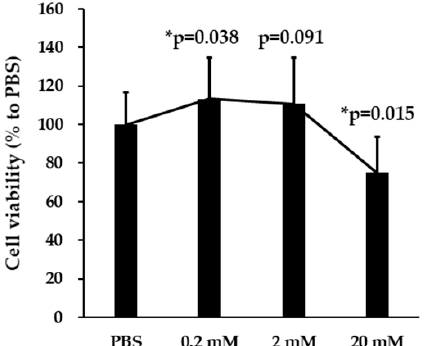
Figure 1. Valproic acid (VPA) has reciprocal concentration-dependent effects on SH-SY5Y cell viability. The 3-(4,5-dimethyl-thiazol-2-yl)-2,5-diphenyl tetrazolium bromide (MTT) assay was used to estimate cell number following 24 h treatment with the indicated VPA concentration. The results were calculated as the 545 nm optical density (OD545) of VPA-treated cultures relative to phosphate-